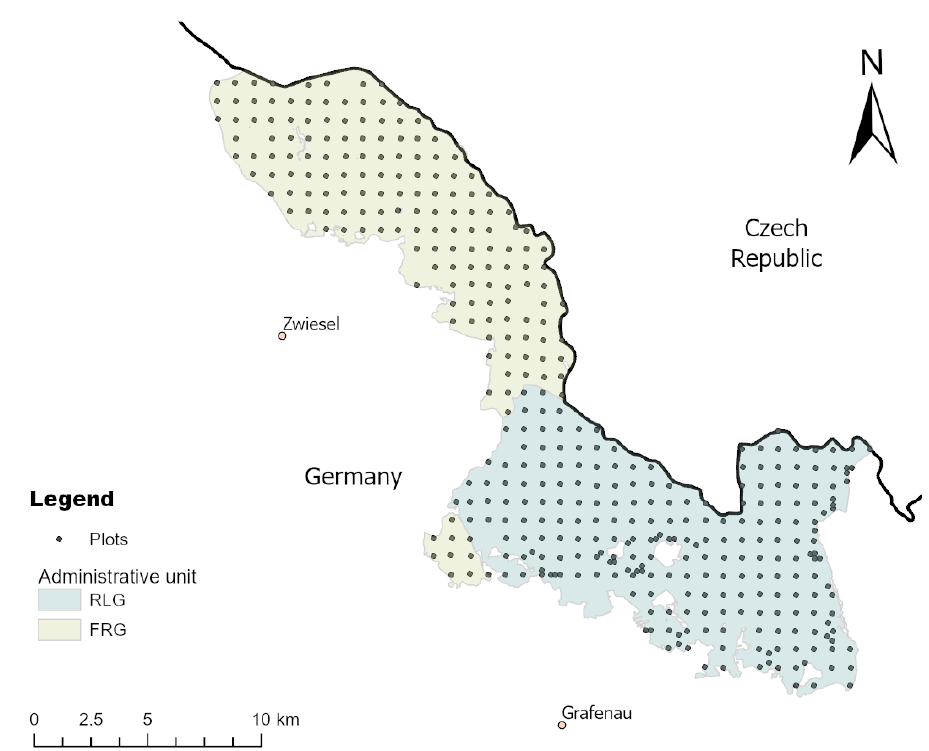
Figure A9. Overview of the administrative organization of the study area (Bavarian Forest National Park); RLG = Rachel-Lusen-Region (light blue); FRG = Falkenstein-Rachel-Region (light green); systematic distributed plots of the regeneration inventory. The few plots which fall out of that grid near the NP’s borders are not incorporated in our analysis.